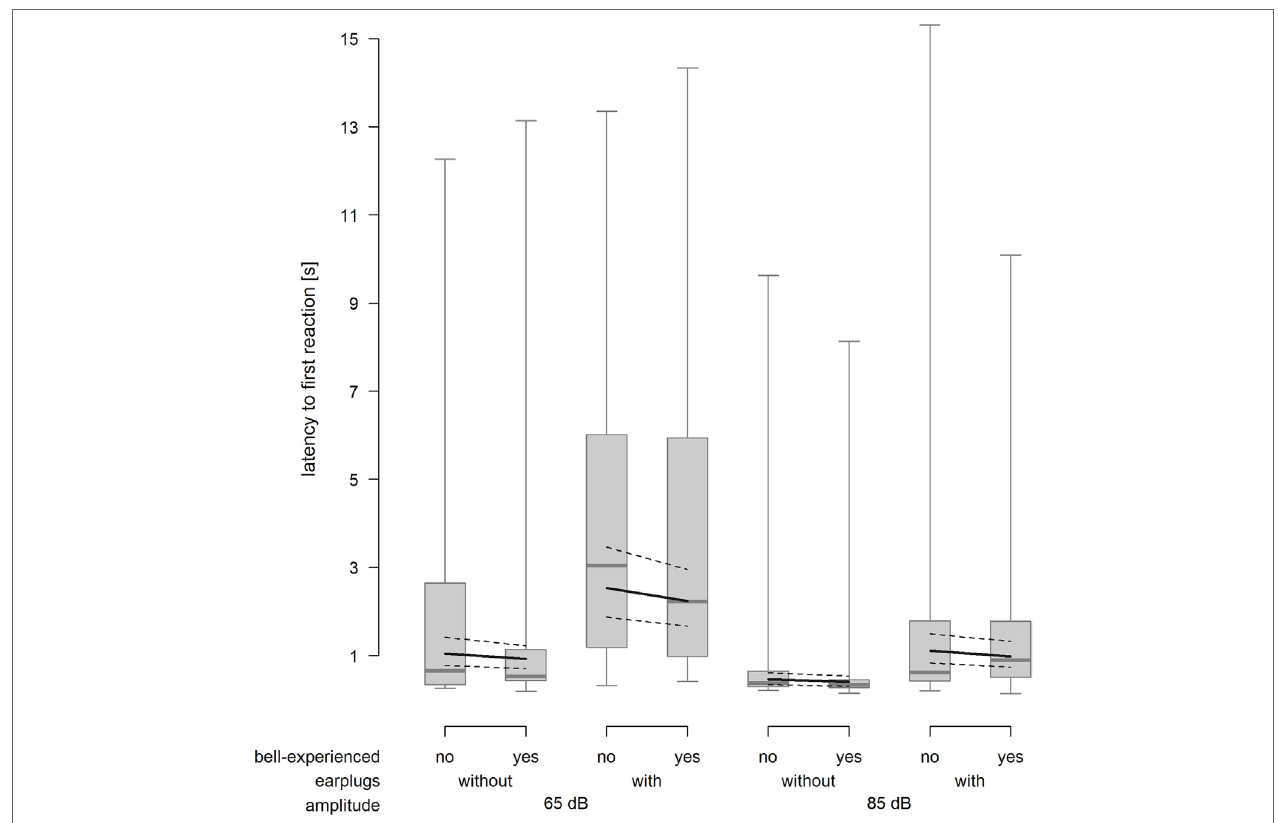
FigUre 4 | Latency to the first reaction 15 s after onset of the playback stimulus depending on bell-experienced (no, yes), earplugs (without, with) and amplitude (65, 85 dB). Descriptive data are presented as box plots indicating observed median, first and third quartiles, and absolute range of data. Solid lines show the model estimation and dotted lines show the lower and upper 95% confidence